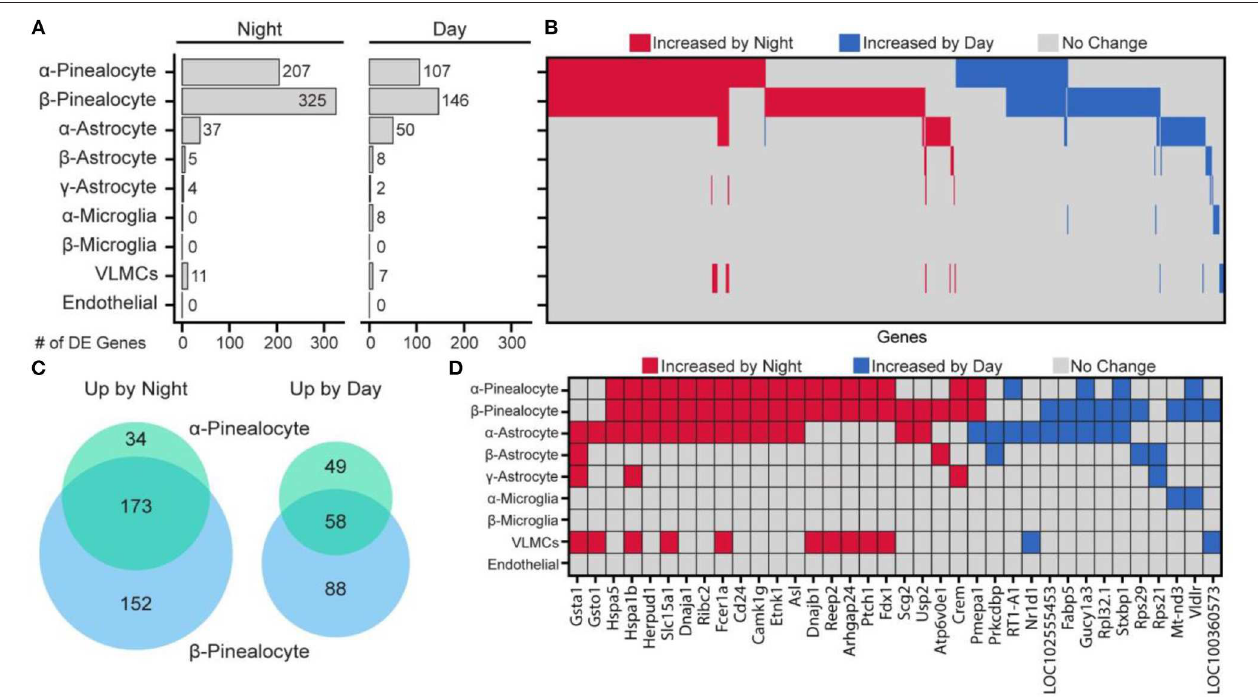
FIGURE 6 | Changes in gene expression between day and night occur in a cell type-specific manner. (A) Number of differentially expressed (DE) genes upregulated by night or day by cell type. DE is p < 0.01 (Wilcoxon rank sum), when expressed in at least 15% of cells in either of the two samples being tested, fold change ≥ 2.0, and effect size ≥ 0.35. (B) Heatmap summary of all 644 DE gene changes by cell type. Each column represents one gene. (C) Venn diagram of number of overlapping DE genes in α - and β -pinealocytes by day and night. (D) Heatmap summary of DE genes found in at least one non-pinealocyte and one other subtype. See also dot plots in SI of Mays et al. (43). Reproduced from Mays et al. (43). This figure and associated legend is published with permission of the original publisher under license